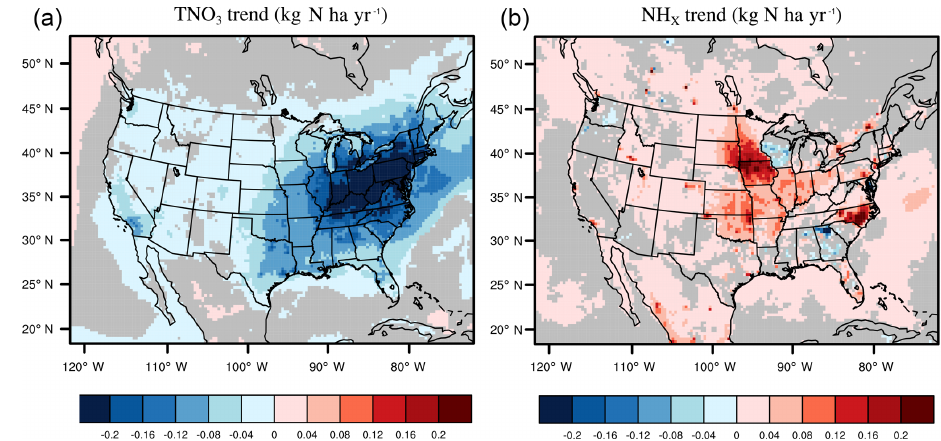
Figure 5. Spatial distribution of the trends for the TDEP of total oxidized nitrogen deposition (TNO 3 , a ), and reduced nitrogen (NH X , b ) from 1990 to 2010. Grey areas on the both plots show p value great than 0.05 for the standard two-tailed Student t test (i.e., areas where trend estimates were not significant at the 95% confidence level). Table 6. Trends for total deposition (WDEP + DDEP, units of kgNha − 1 yr − 1 for nitrogen deposition including TNO 3 , NH x and TIN, and kgSha − 1 yr − 1 for TS) over the 10 ecoregions. The bolded values indicate trends that are statistically significant with the P value less than 0.05 for the Student’s t